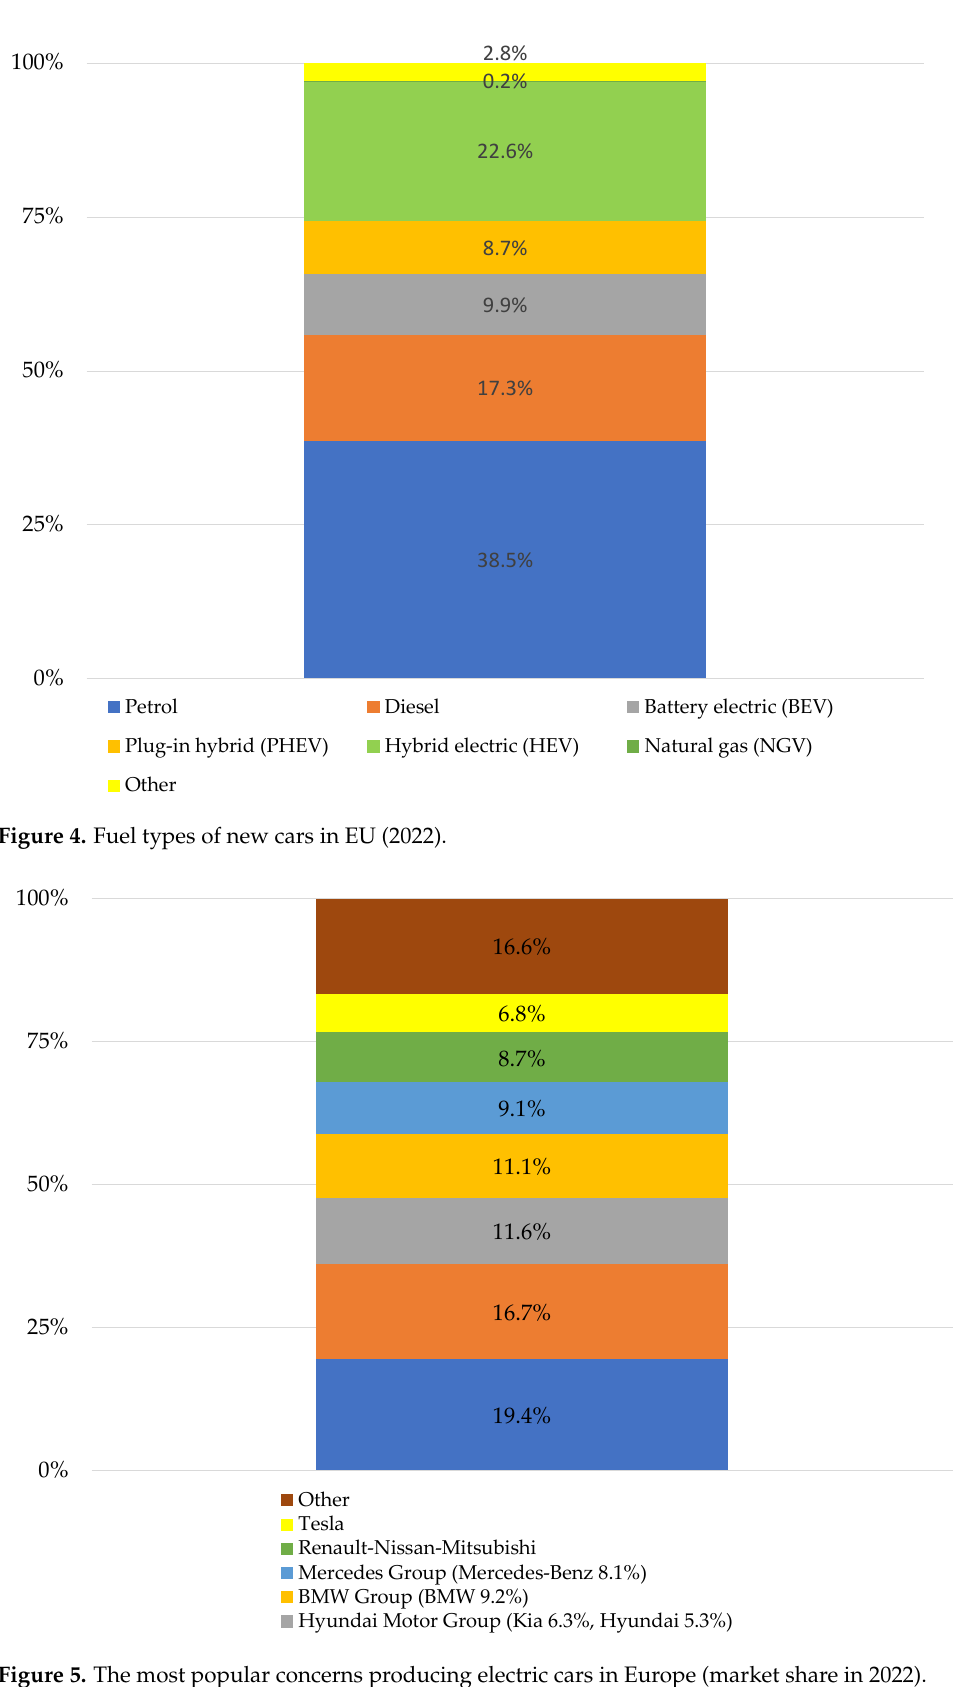
Figure 5. The most popular concerns producing electric cars in Europe (market share in 2022).